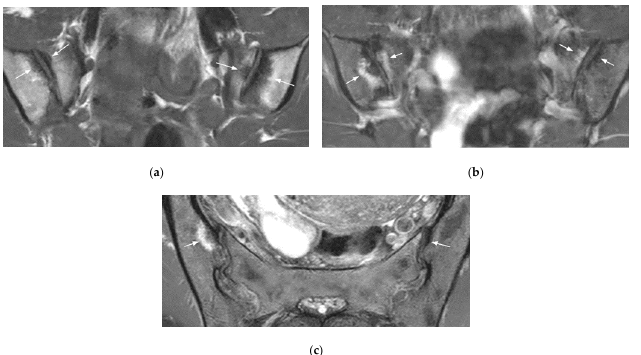
Figure 3. Bilateral mechanical changes in the SIJ (arrows) (coronal oblique T1- ( a ) and fat-suppressed T2- ( b ) weighted images, axial oblique T2-weighted image ( c ). The changes are mainly edematous on the sacral side of the SIJ, sclerotic on the right iliac side, and both edematous and sclerotic on the left iliac side. They are located at the anterior part of the mid-third of the SI.